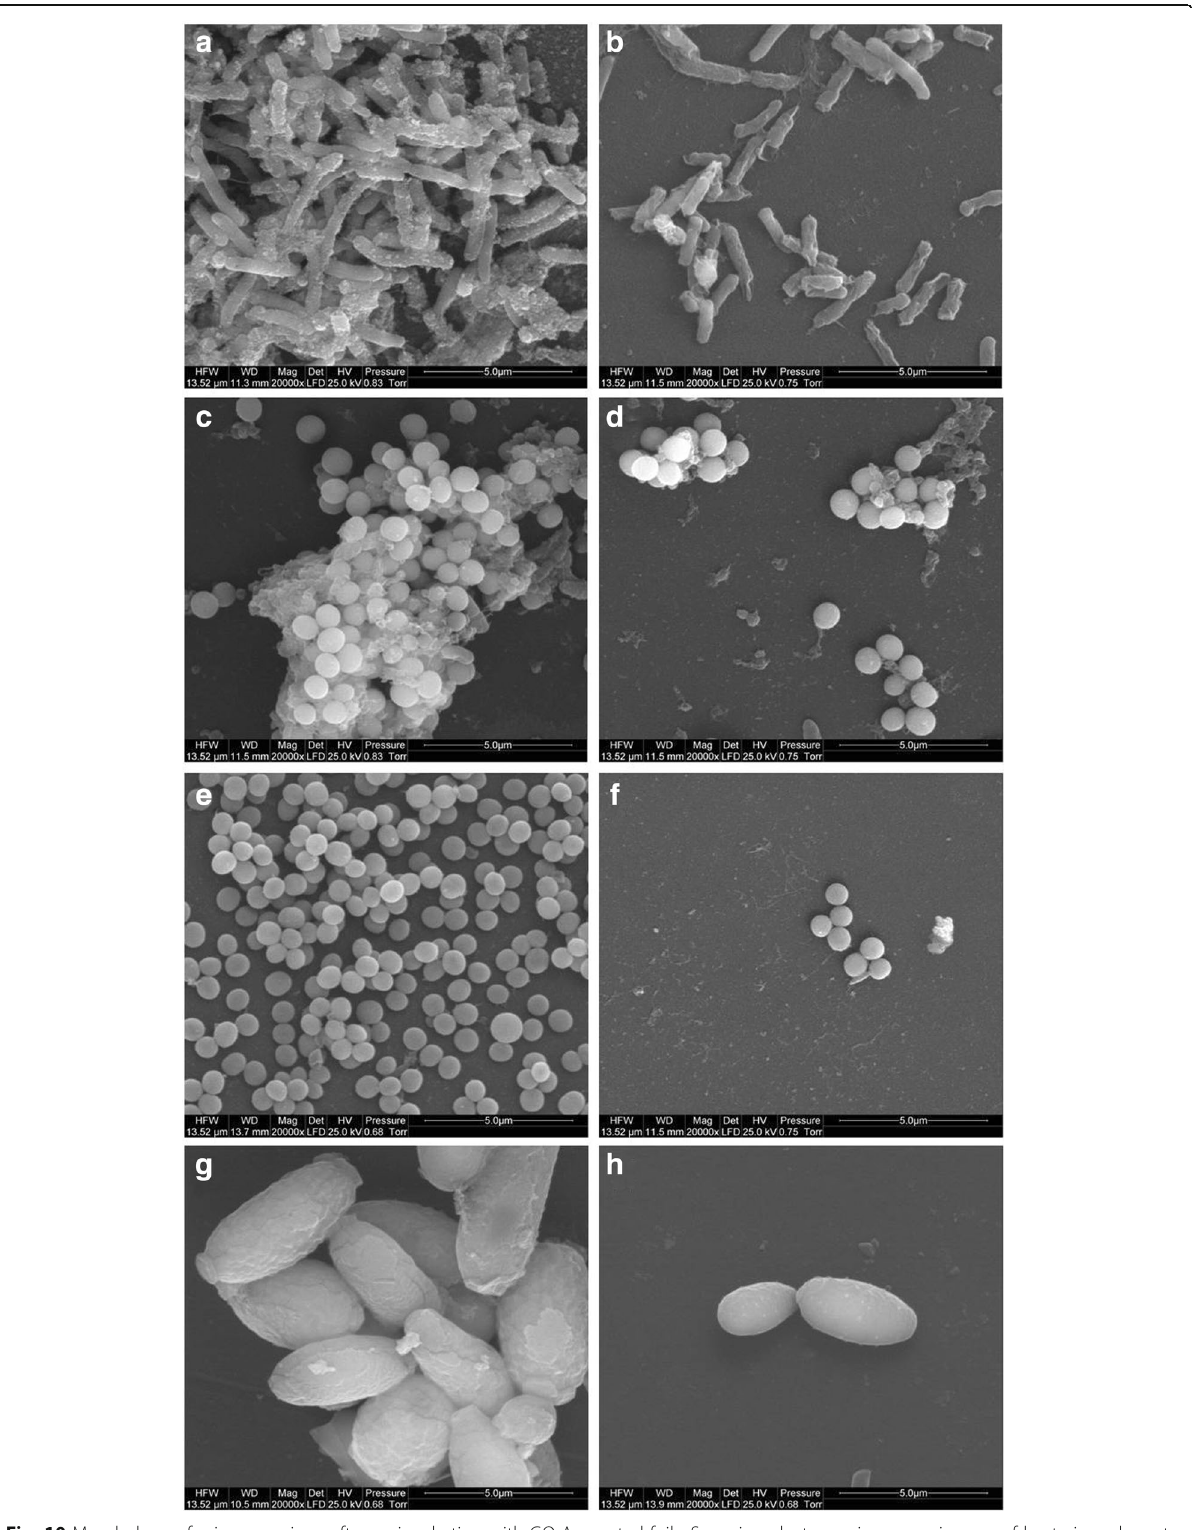
Fig. 10 Morphology of microorganisms after co-incubation with GO-Ag-coated foils. Scanning electron microscopy images of bacteria and yeast in the control foils ( a , c , e , g ) and foils coated with GO-Ag ( b , d , f , h ) after incubation at 37 °C for 24 h. E . coli ( a , b ), S . aureus ( c , d ), S . epidermidis ( e , f ), and C . albicans ( g , h ) show decreased growth and deformed morphology after co-incubation with GO-Ag-coated